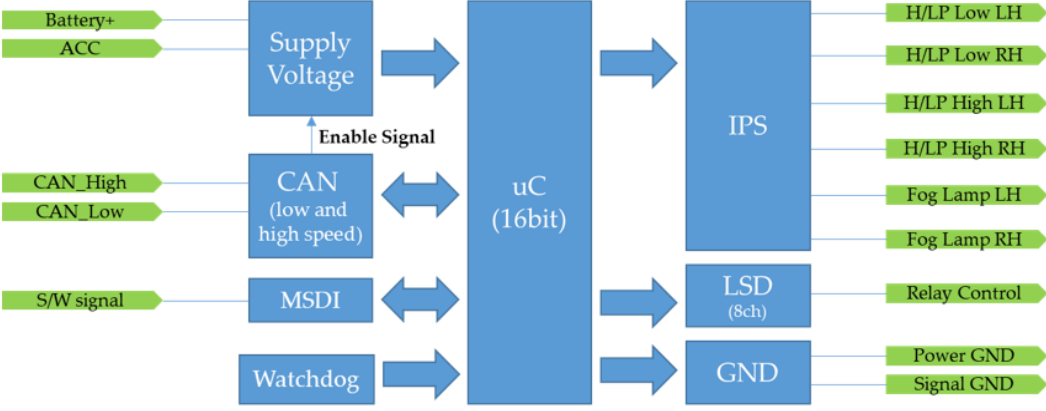
Figure 3. Schematic of the implemented SJB.